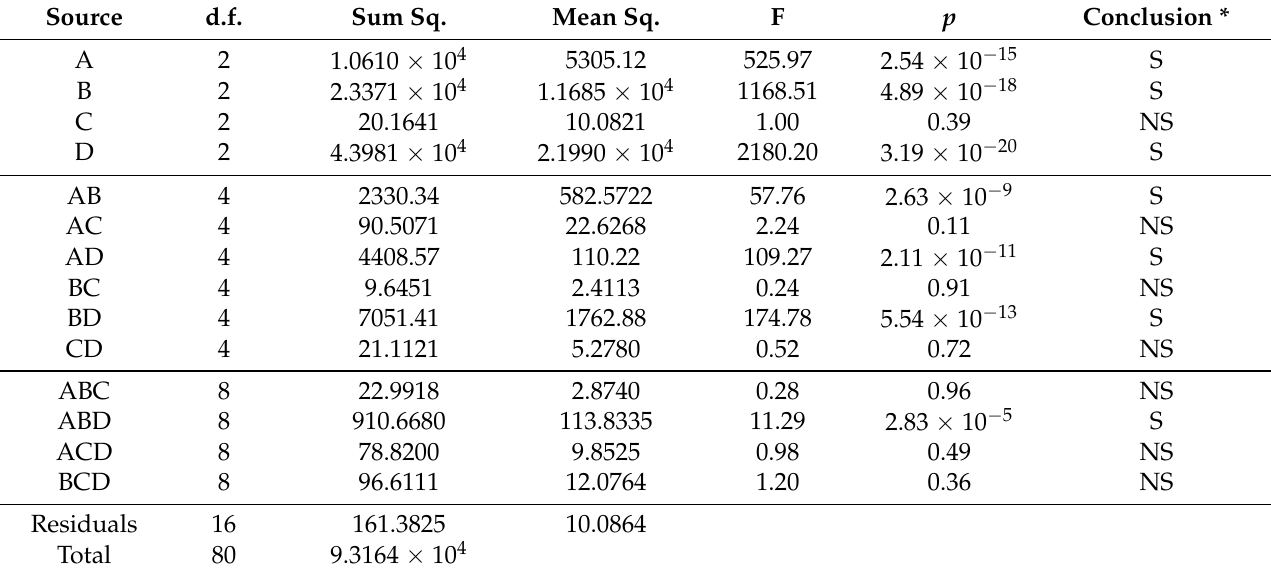
Table 5. Yield Strength Results for the Four-Factor ANOVA.